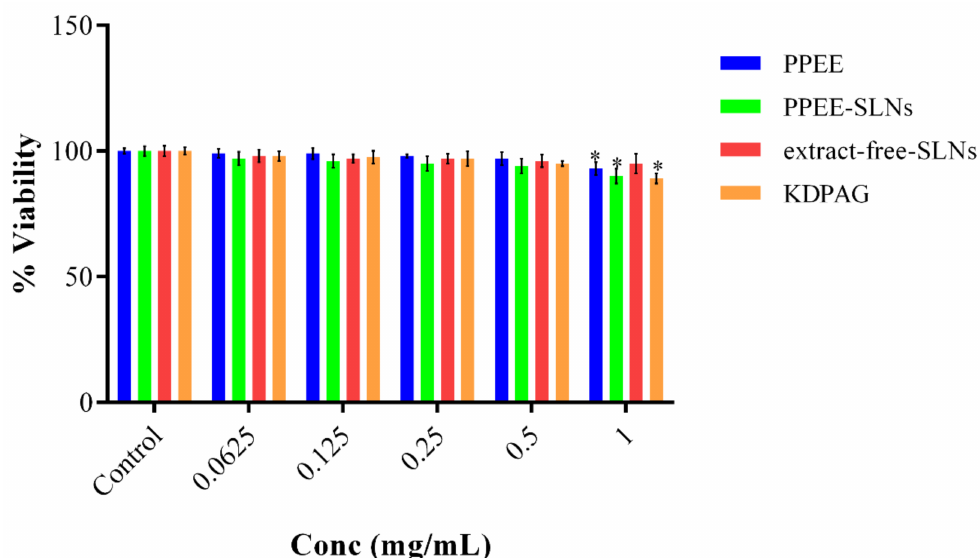
Figure 2. Viability of human keratinocytes treated with PPEE, PPEE-SLNs, Extract-free-SLNs, and KDPAG for 24 h; At the concentration of 1 mg/mL, there was a significant reduction in the viability of the cells treated with PPEE, PPEE-SLNs and KDPAG. The data represents% cell viability at each concentration (mean ± S.D.), n = 3. Statistical significance using One-way ANOVA, followed by Tukey’s test: * p < 0.05